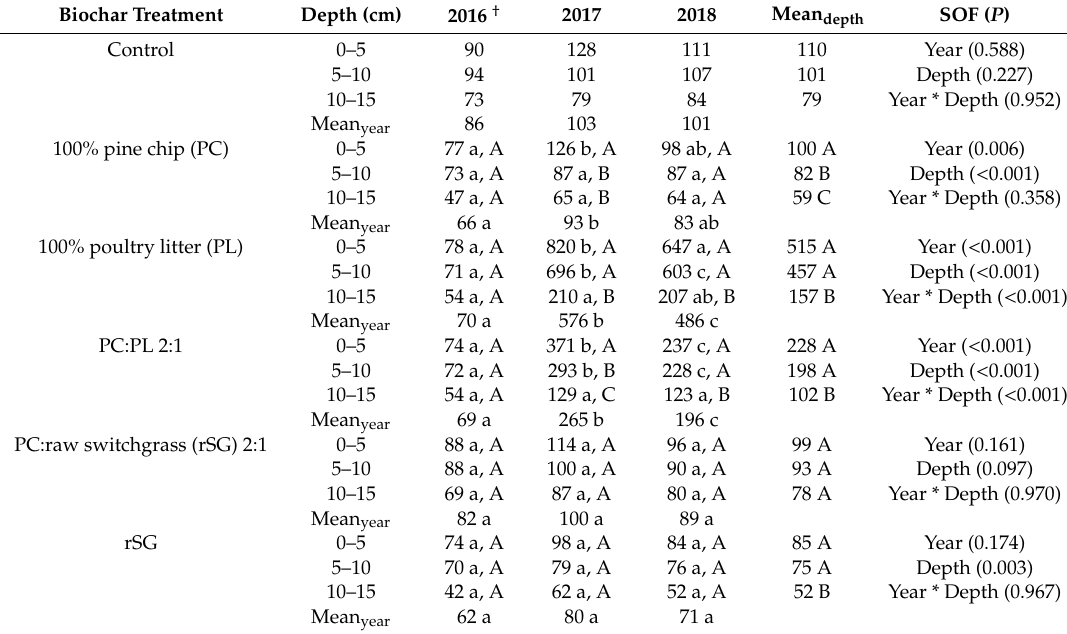
† lower case letter indicates significant di ff erences among means between columns, while a capital letter indicates significant di ff erences among means within a column using a 2-way ANOVA at P < 0.05 level of significance. Table 9. Mean Mehlich 1 P contents (kg / ha) by soil depth per year of study (SOV = source of variation, P value in